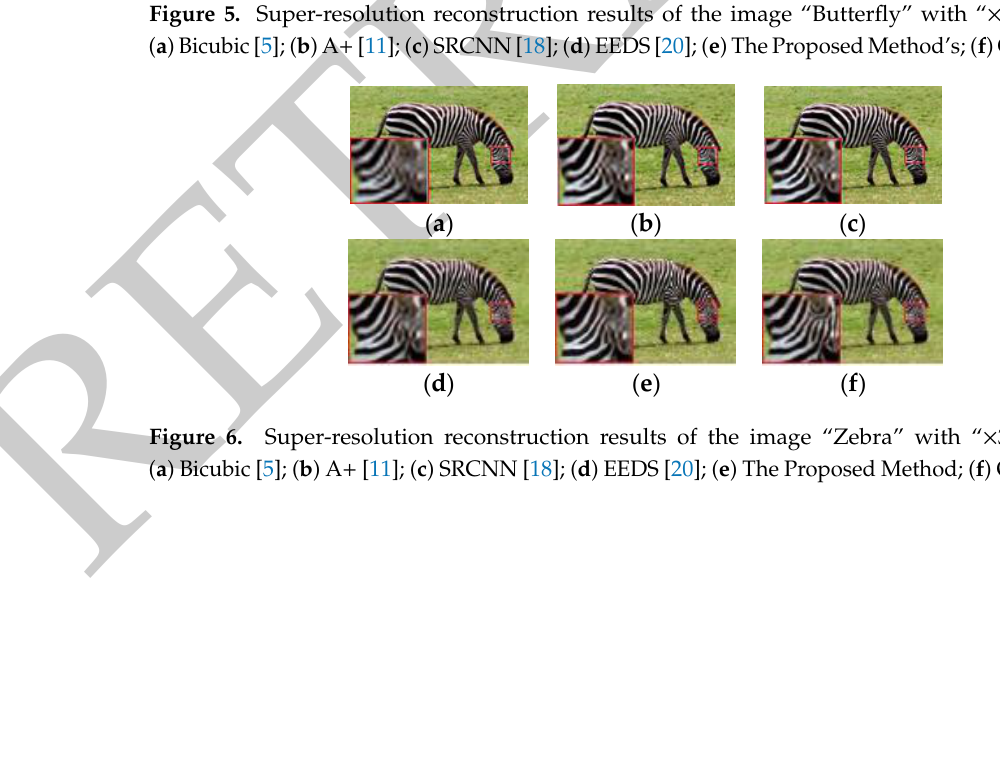
( f ) Figure 7. Super- resolution reconstruction results of the image “ Comic ” with “ ×3 ” scale factor. ( a ) Bicubic [5]; ( b ) A+ [11]; ( c ) SRCNN [18]; ( d ) EEDS [20]; ( e ) The Proposed Method; ( f ) Original Image. Table 1. Average Peak Signal-to-Noise Ratio (PSNR) and Structural Similarity Index (SSIM) at different reconstruction scales on Set5 and Set14 datasets. Datas et